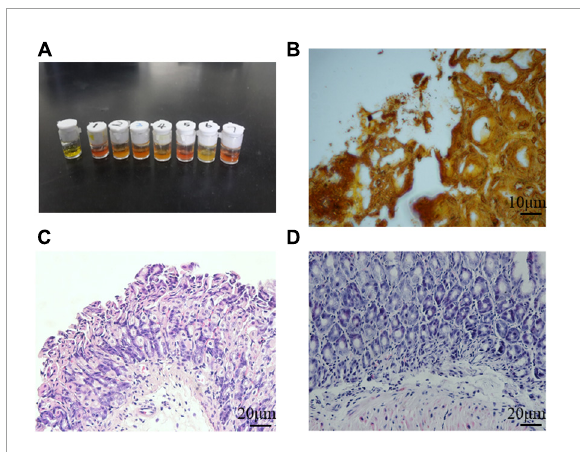
FIGURE3 Helicobacter pylori successfully colonized mouse stomach tissue. (A) Rapid urease reaction showed positive results in infected mice and negative results in control mice. (B) Several black rod-shaped structures were observed after Warthin-Starry silver staining. Scale bar = 10 µ m. (C,D) Hematoxylin-eosin staining of the gastric mucosa of uninfected (C) and infected (D) mice. Chronic gastric mucosal inflammation could be observed in the infected group. Scale bar = 20 µ m.